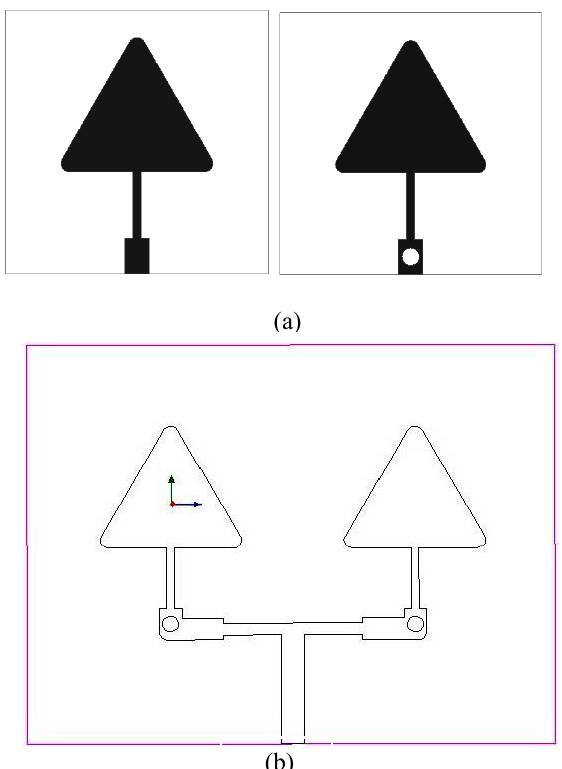
Figure 2: (a) Modified triangular patch antenna (b)Modified 1×2 triangular patch antenna array